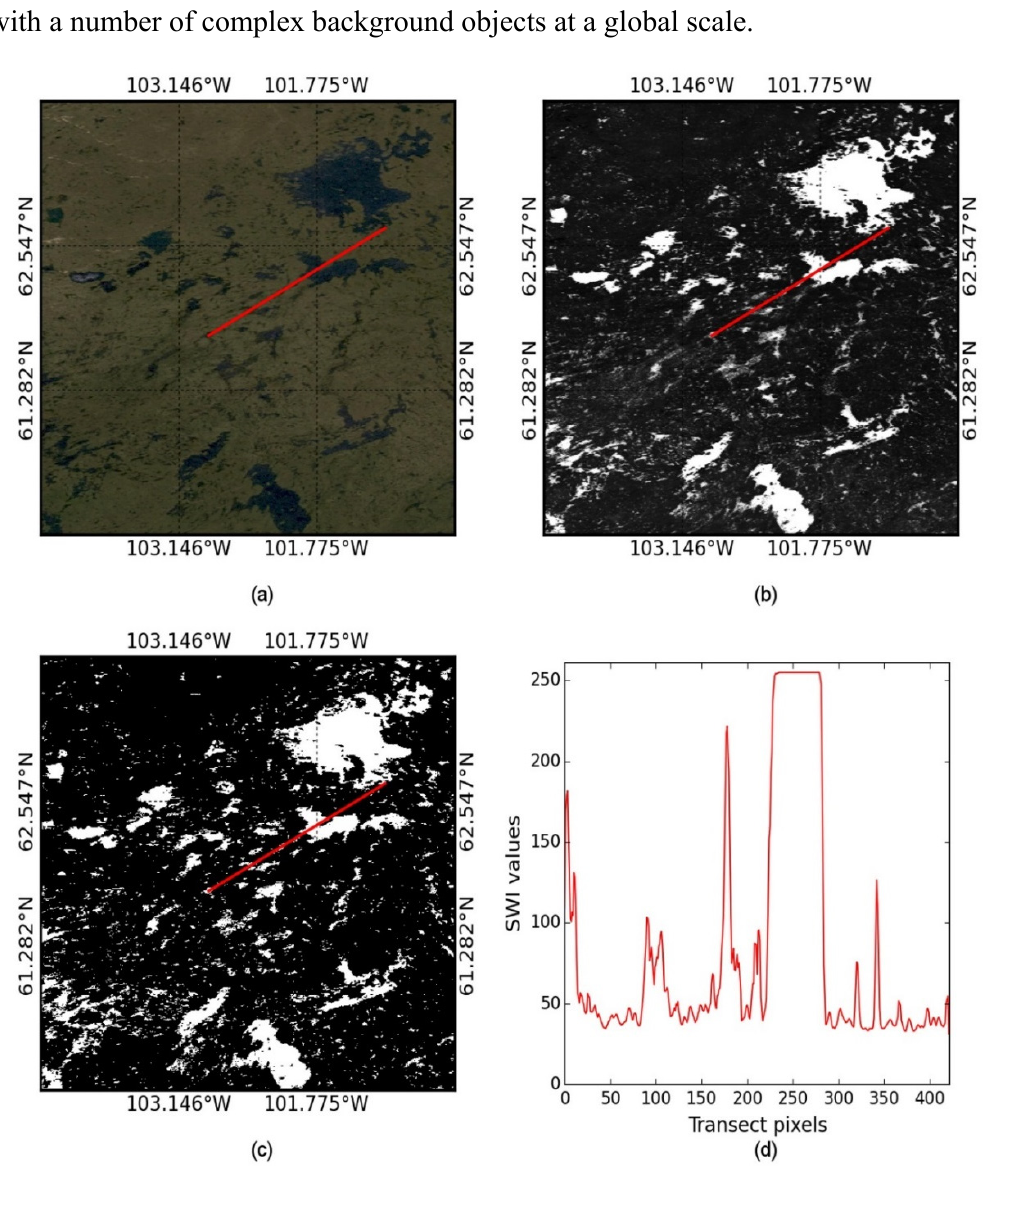
Figure 14. Performance of SWI based extraction of water cover in case of narrow water bodies of water bodies: ( a ) MODIS true-color image, ( b ) SWI image, ( c ) Extracted water cover, ( d ) Profile plot of SWI along the red line